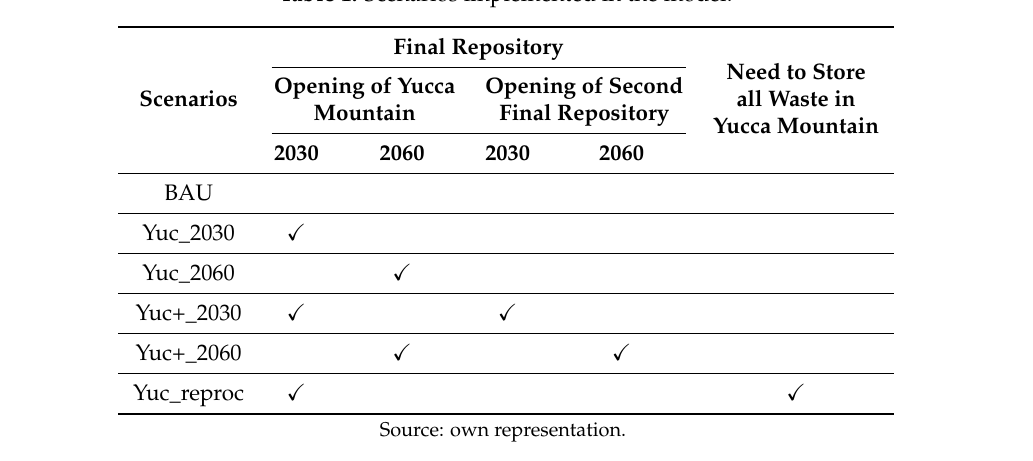
Figure 3. Scheme of model. Source: own representation. Table 1. Scenarios implemented in the